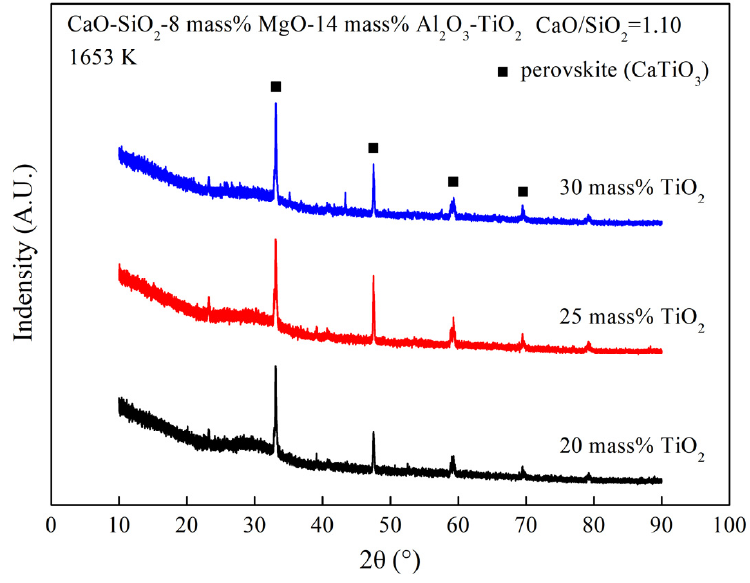
Figure 4. XRD curves of the slag containing different TiO 2 content at 1653 K.